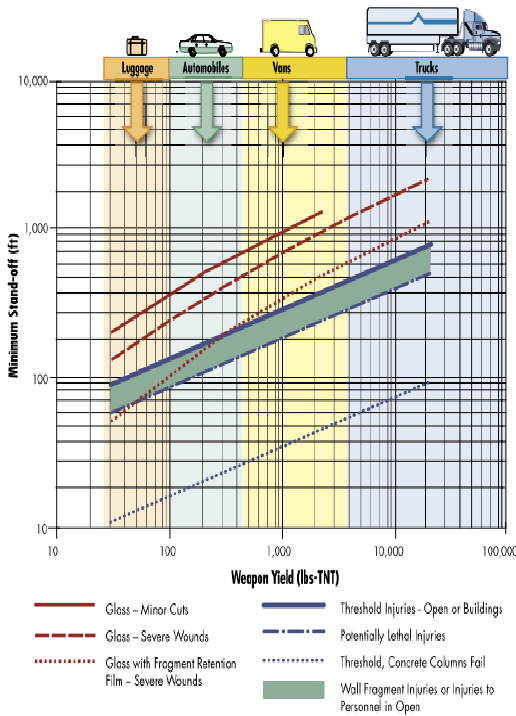
Fig. 10: Explosives environments with blast range to effects, [9].